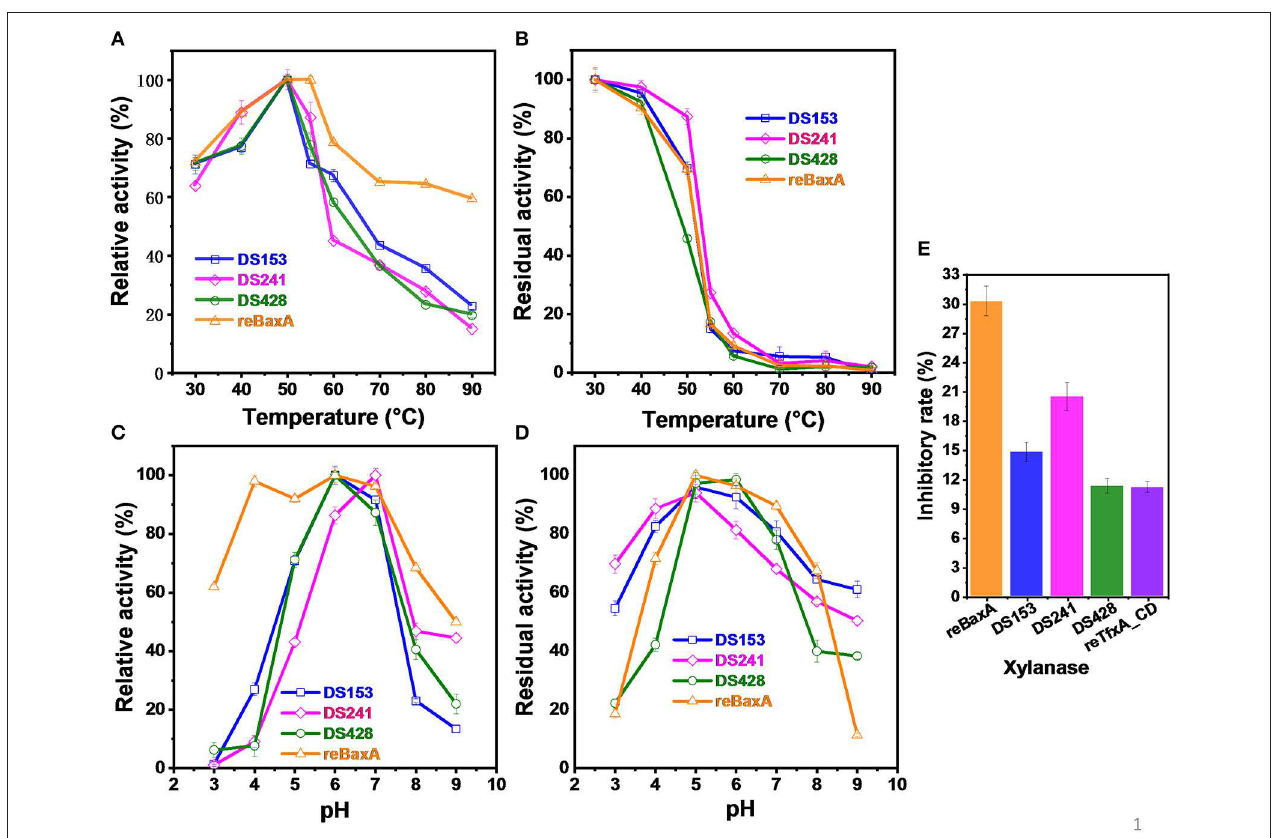
FIGURE 3 | Enzymatic properties of reBaxA and three mutants. (A) Effect of temperature on activity of xylanases. 0.5% beechwood xylan was used as substrate. The highest activity was taken as 100% and the corresponding temperature was the optimum temperature. (B) Thermostability of xylanases. 0.5% beechwood xylan was used as substrate. The activity of xylanase under the optimum conditions was taken as 100% in assay of thermostability, and then the residual activity was assayed. (C) Effect of pH on activity of xylanases. 0.5% beechwood xylan in different pH buffer was used as substrate to explore effect of pH on activity. The highest activity was taken as 100% and the corresponding pH was the optimum pH. (D) pH stability. The activity of xylanase under the optimum conditions was taken as 100% in assay of pH stability, and then the residual activity was assayed. (E) Inhibitory activity of rePRIXI on xylanase. The rePRIXI (0.3mg) was mixture with 5 types of xylanases (0.3U) at 50 ◦ C for 40min, respectively. And then the residual activity of xylanase was measured under their corresponding optimal condition. The inhibitory rate was obtained. Triplicate experiments were conducted for each